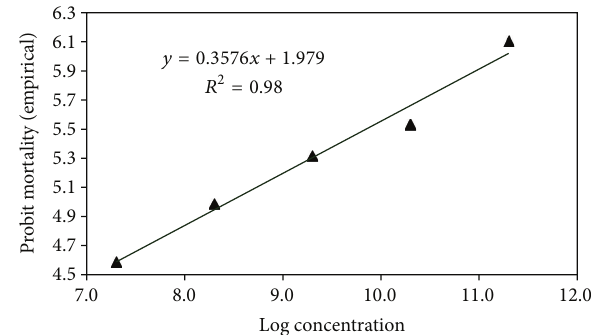
Figure 5: Log concentration probit mortality response of A. disper- sus to M. anisopliae (M1 strain).